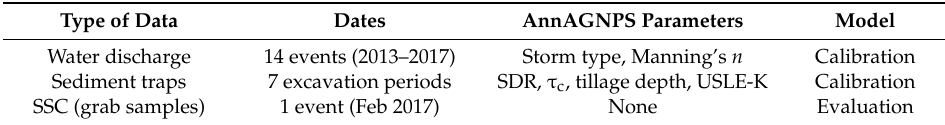
Table 4. Field data collection and time periods for model